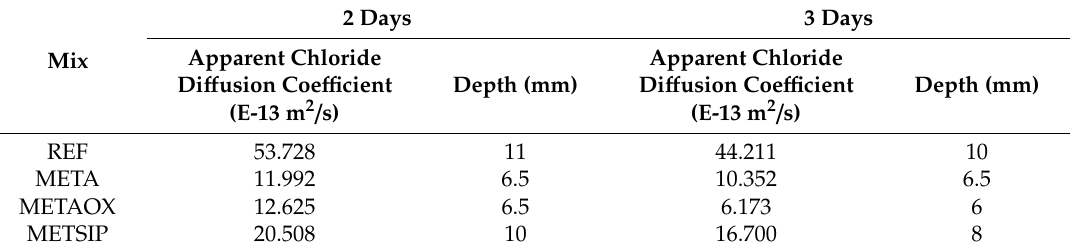
Table 5. Chloride di ff usion coe ffi cient at two and three